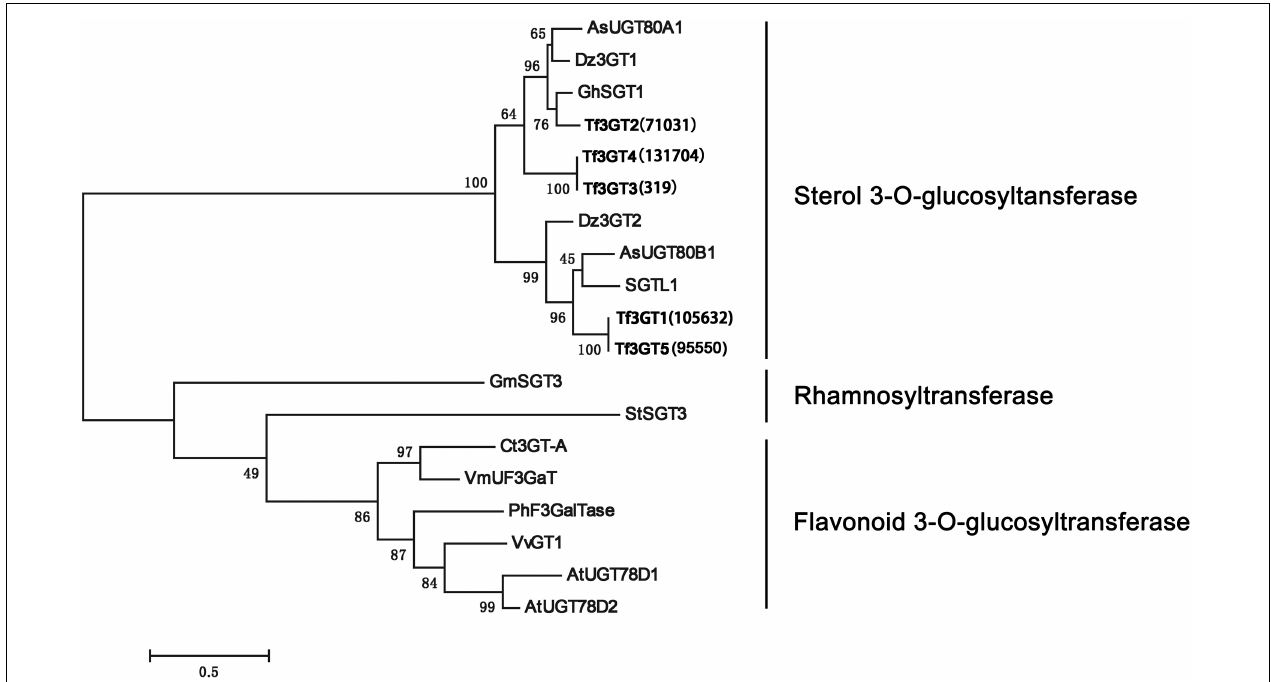
FIGURE 2 | Phylogenetic analysis of the four TfS3GTs together with the previously characterized glucose- or rhamnose- transferases. The evolution history was inferred based on the neighbor-joining method using the software MEGA 7.0 (Kumar et al., 2016). The analysis incudes 14 previously published sequences, and their Genbank accession numbers are listed in the Supplementary Table 2 . The bootstrap values are 500, and the scale bar represents 0.5 amino acid substitutions per